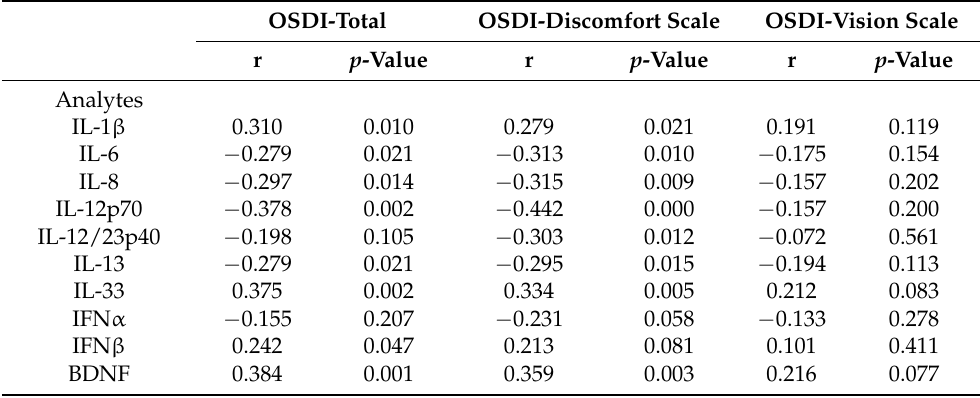
Table 1. Association between the levels of tear soluble factors and immune cell proportions on the ocular surface with ocular disease index